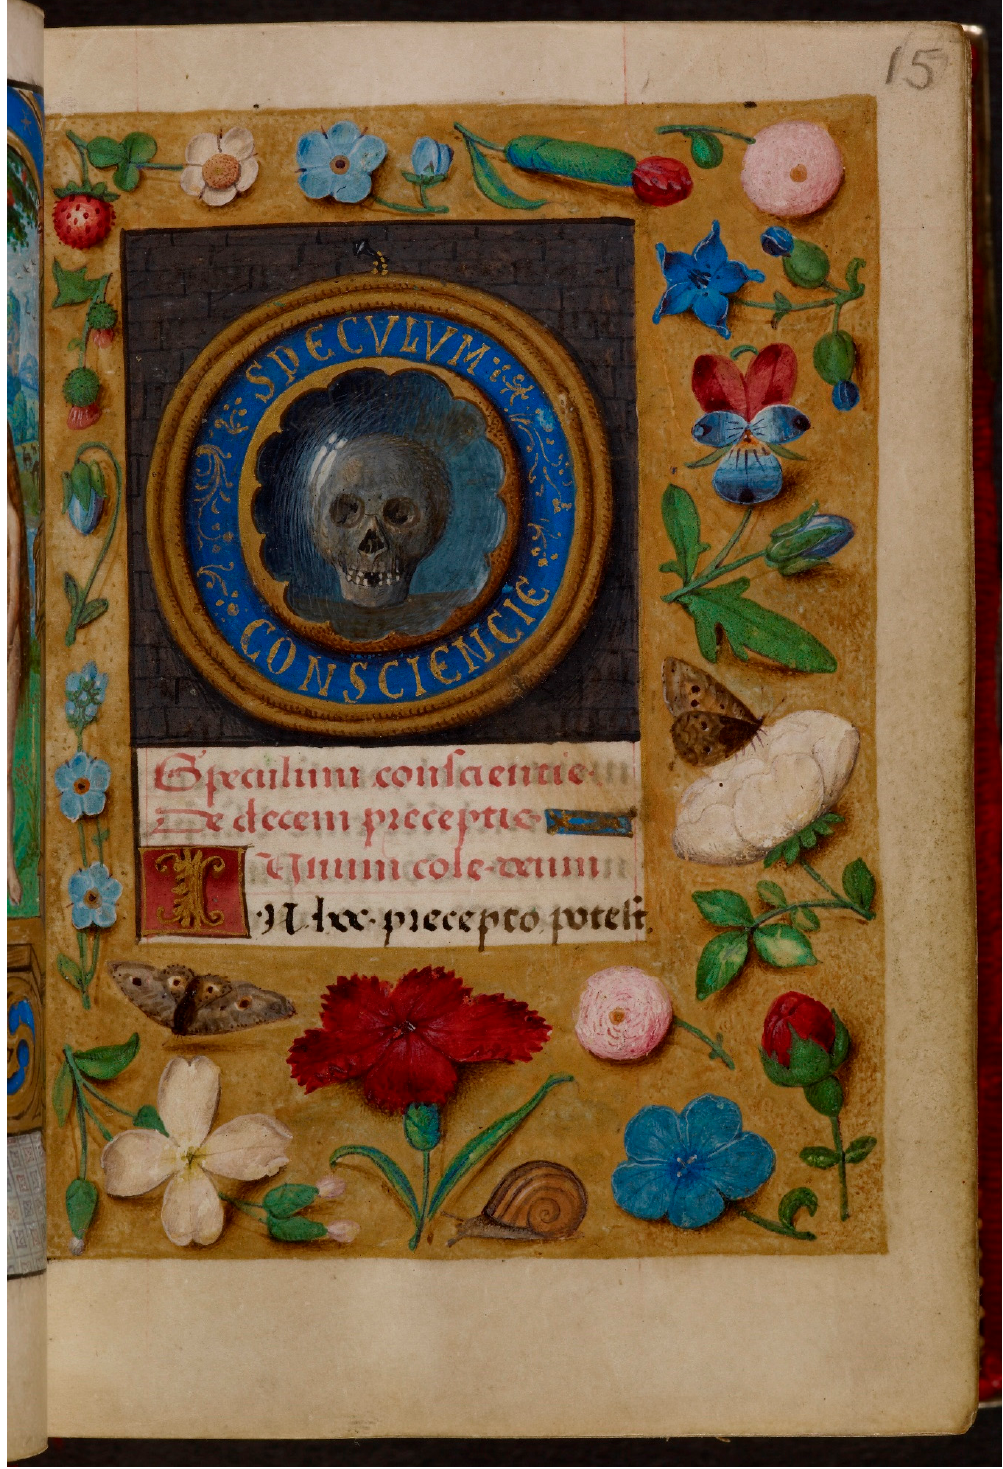
Figure 5. London, British Library, Add. MS 18852, fol. 15r. Speculum conscientie.